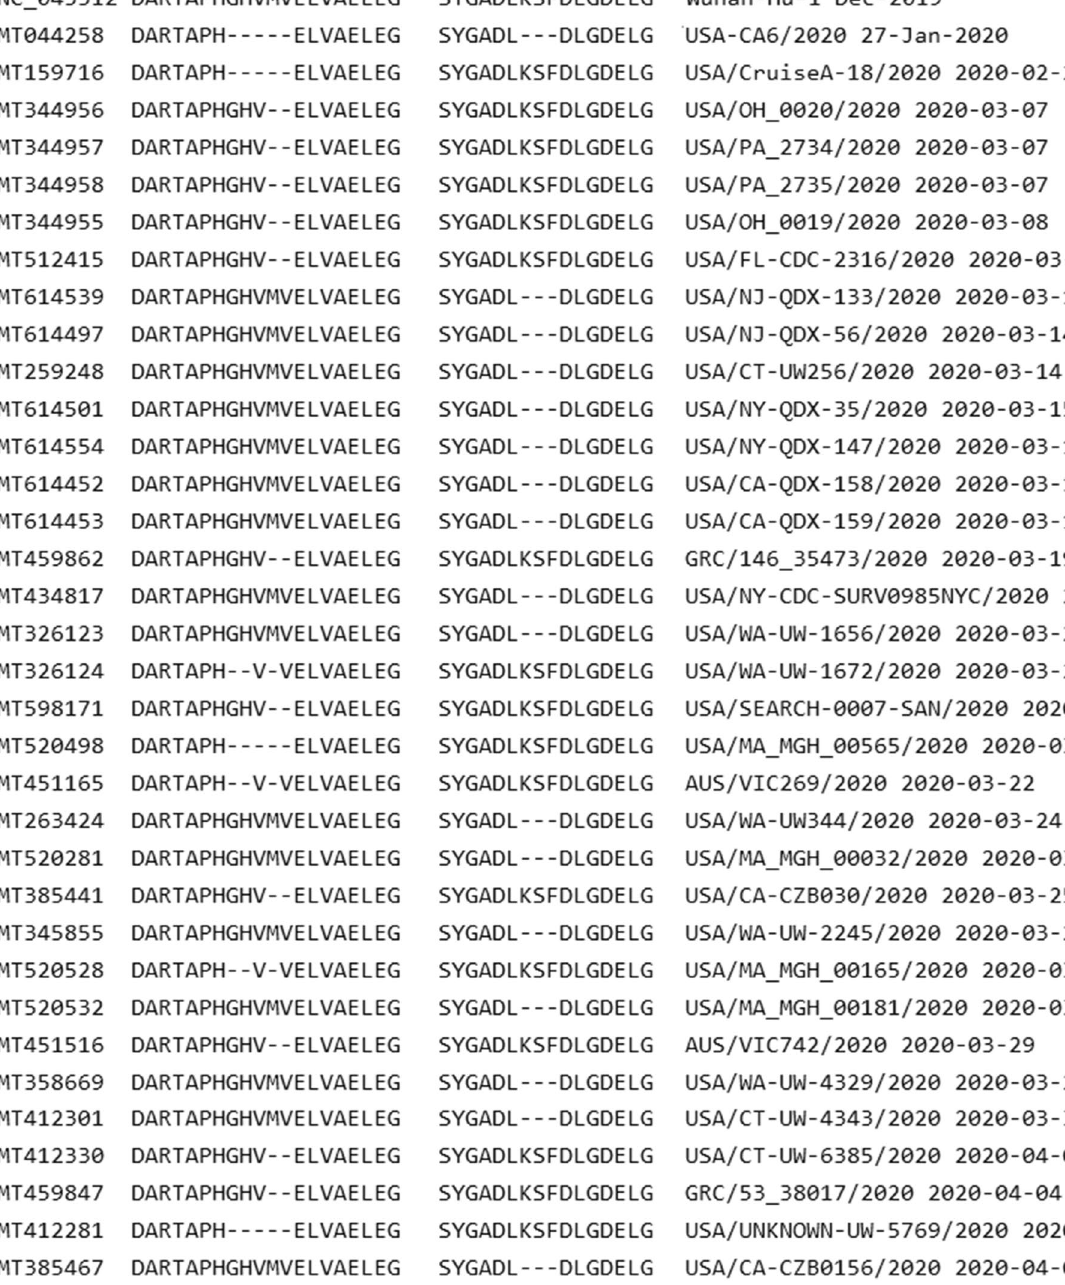
lar to ORF7b, this is a stable gene. There are 8 distinct nonsynonymous mutations, including I4L, A8V, S23F, R24L, R24C, A28V, D31Y and V33I. Those occurring in 2 sequences or more are presented in Table 9.